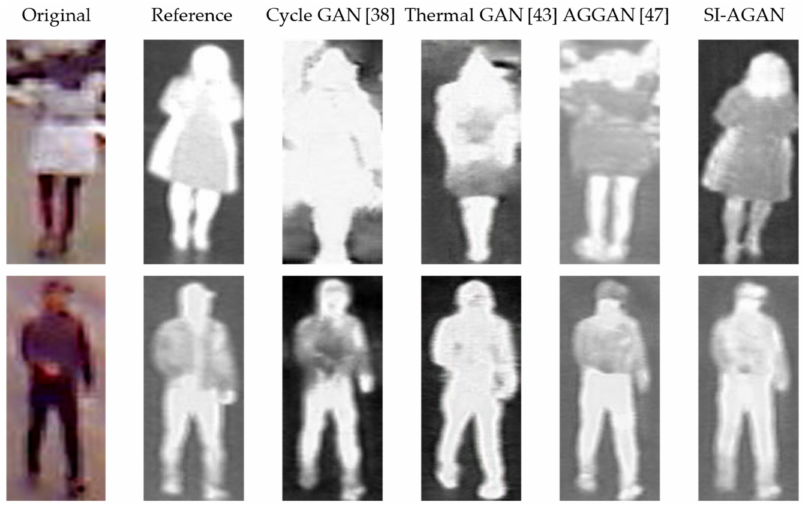
Figure 13. Comparisons of synthesized images according to different GAN models.